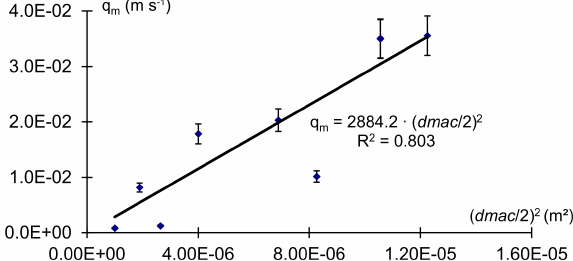
Figure 4. Linear regression of the flux rate within the macropore on the macropore radius (dmac / 2) at the Spechtacker study site (edited figure, adopted from Zehe and Flühler, 2001b). This relation was derived from measurements of saturated flow through undisturbed soil columns containing worm